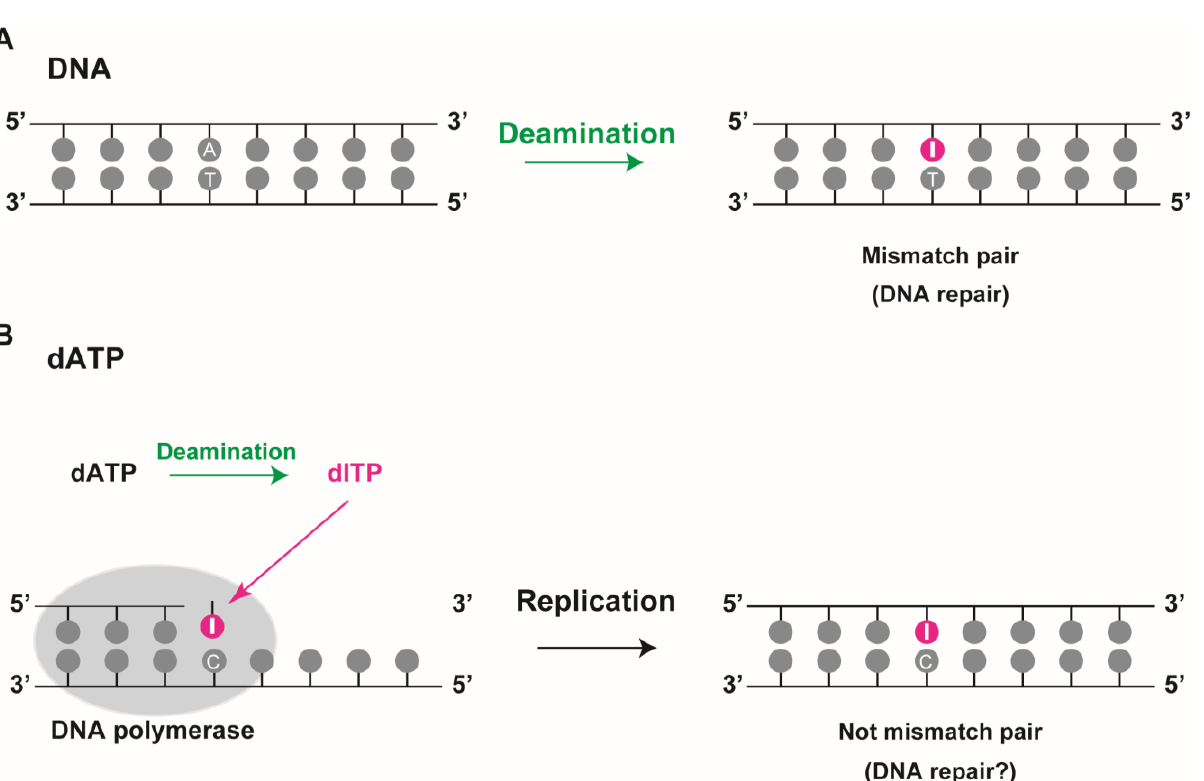
Figure 2. Deoxyinosine in DNA. ( A ) Deoxyinosine is produced by deamination of